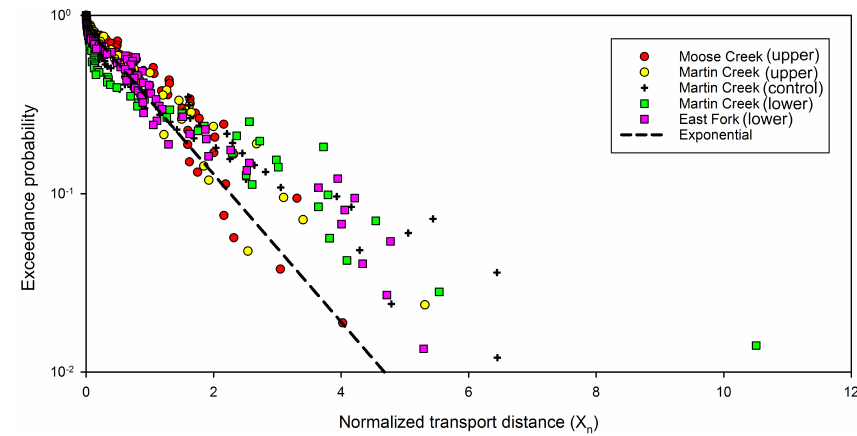
Figure 8. Normalized transport distances (X n ; Eq. 1) in all five study reaches, with exponential fit plotted for comparison.